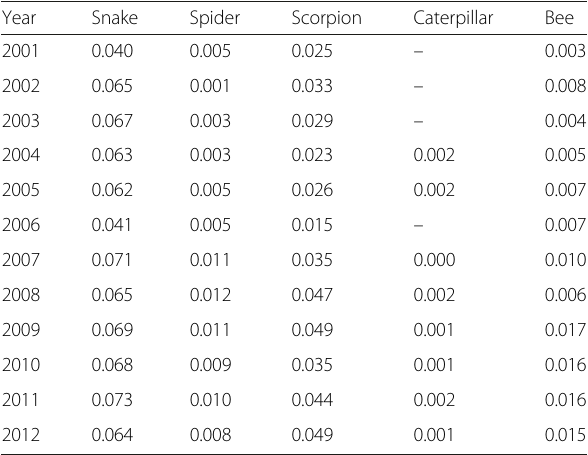
Table 4 Annual mortality associated with envenomations per 100,000 population in Brazil according to the venomous animal,